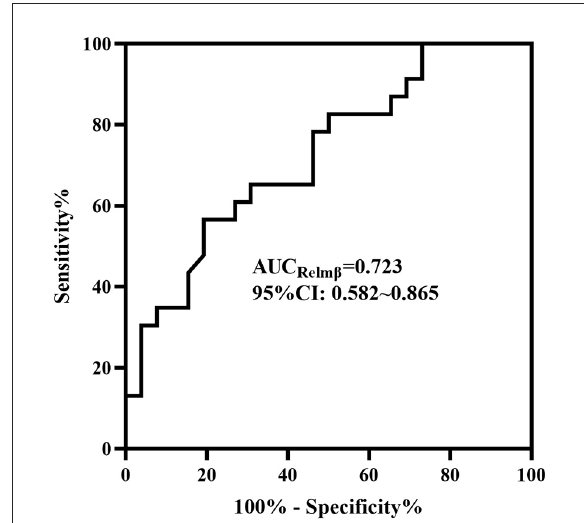
FIGURE3 The ROC curve of Relm β . The AUC of Relm β was 0.723 (95% CI: 0.582–0.865).